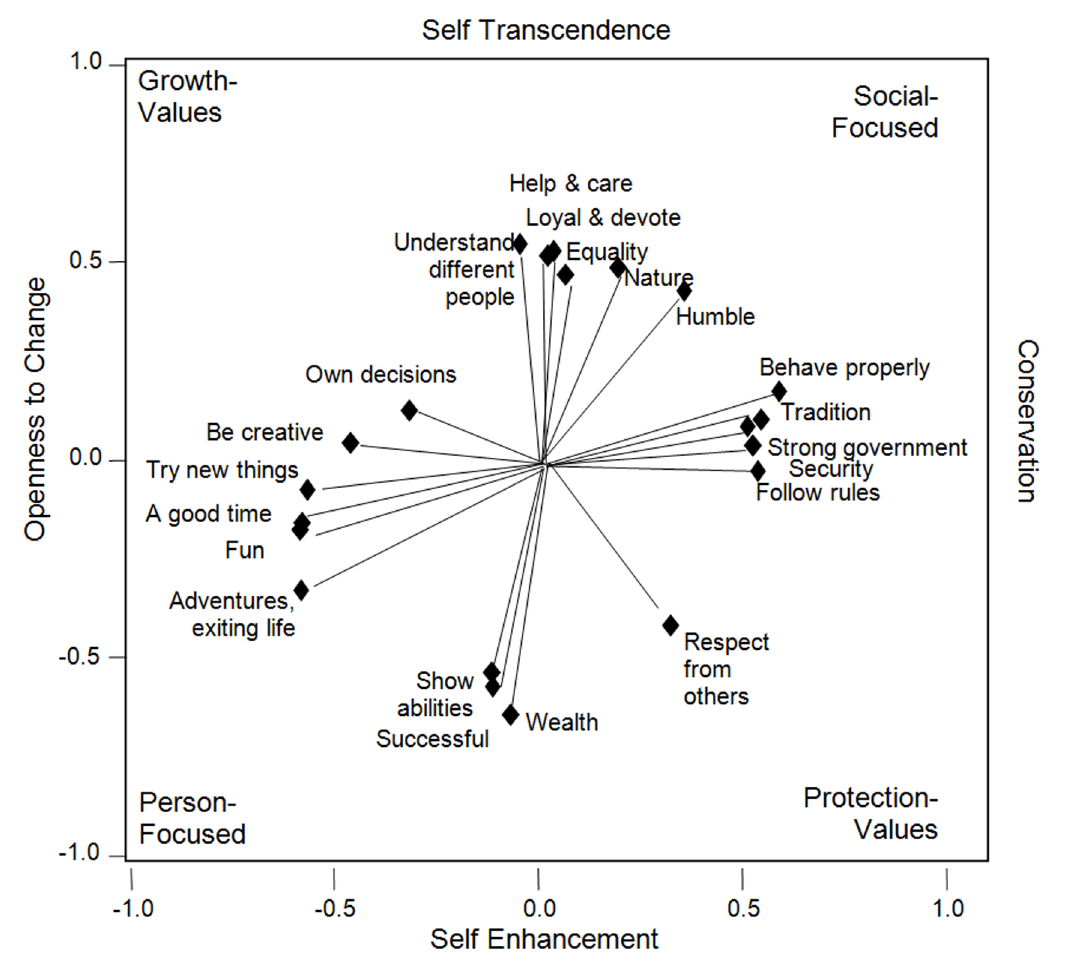
Figure 2. Factor loadings of the ipsated PVQ21